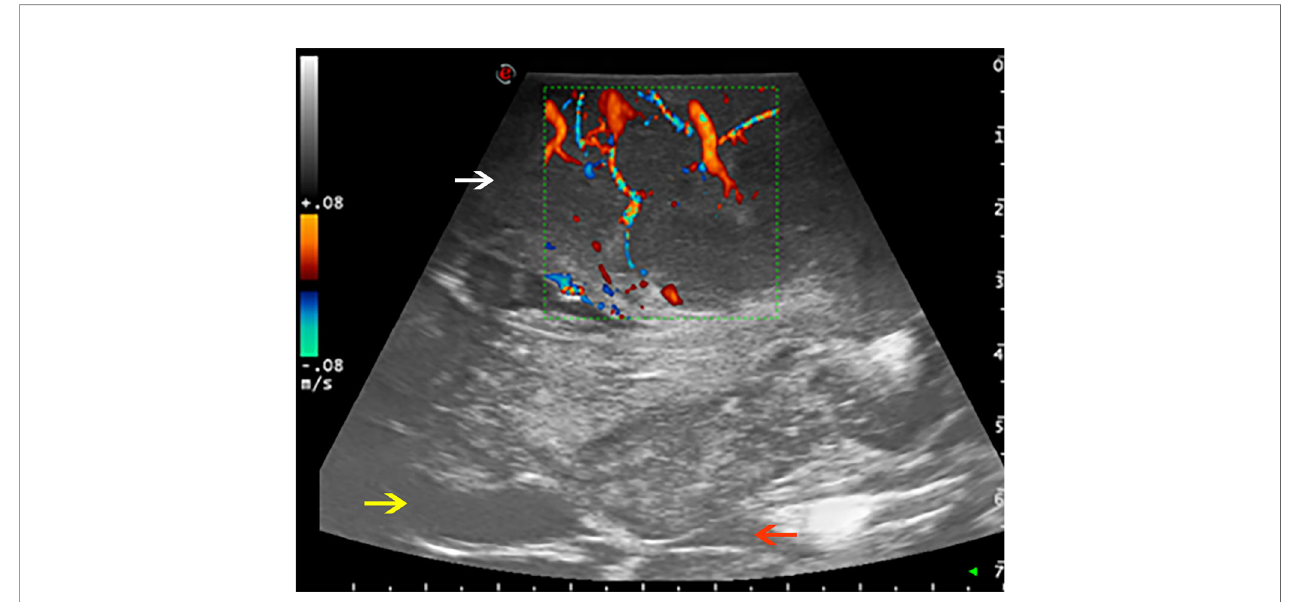
FIGURE 1 | Color Doppler used to evaluate the perfusion pattern of a fronto-temporo-parietal GBM (case no. 6). White arrow: glioblastoma. Yellow arrow: frontal horn of lateral ventricle. Red arrow: third